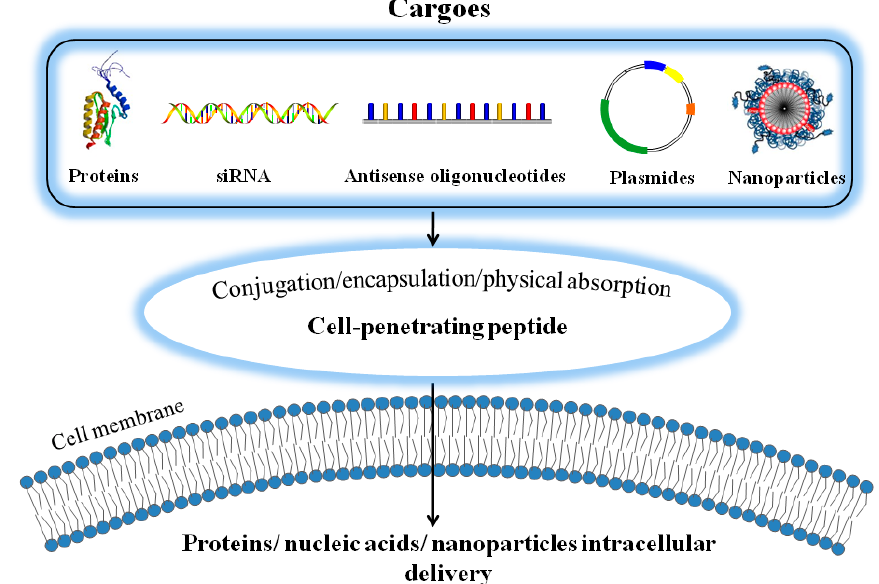
Figure 1. Cell penetrating peptide (CPP)-assisted strategies employed in achieving intracellular delivery of bio-macromolecular compounds and nano-carriers.